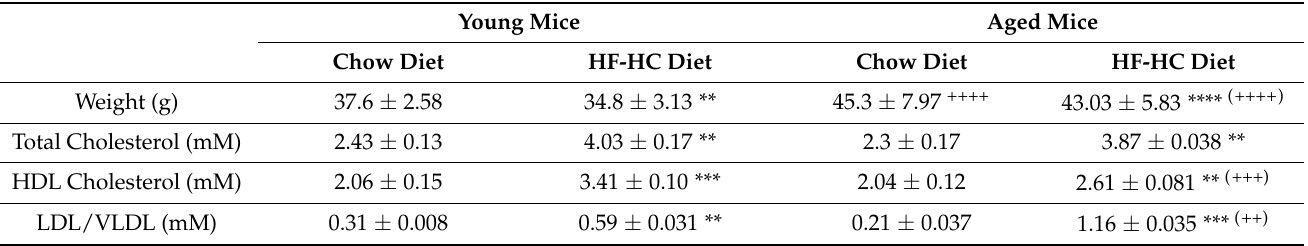
Table 1. Effect of high-fat, high-cholesterol diet on total and HDL cholesterol. Young Mice Aged Mice Chow